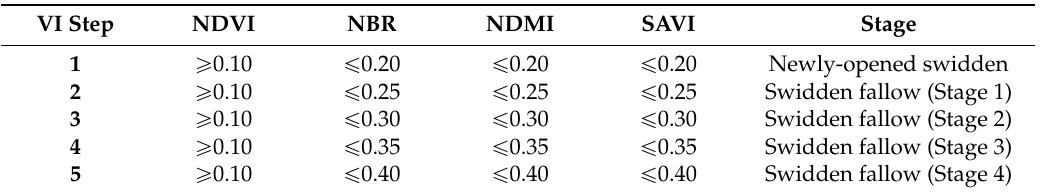
Table 2. Multi-step threshold values used for detecting and delineating the swidden fields and fallows at different regeneration stages in